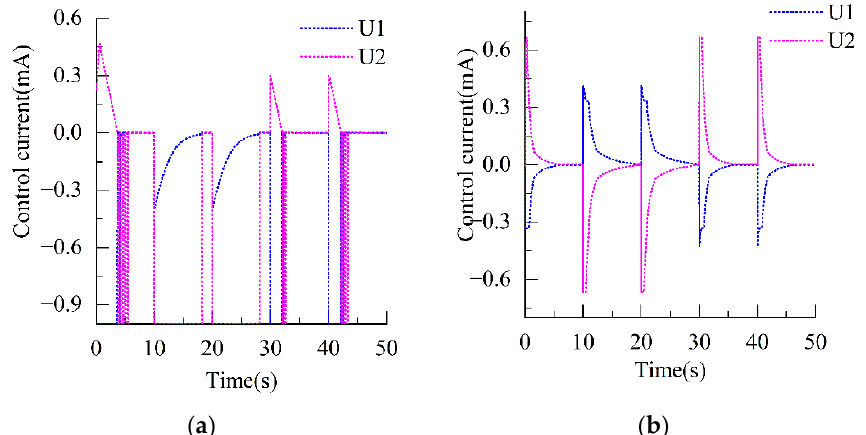
Figure 16. Signals of the electric proportional valve. ( a ) IM-MO valve signals. ( b ) VUFC valve sig- nals.